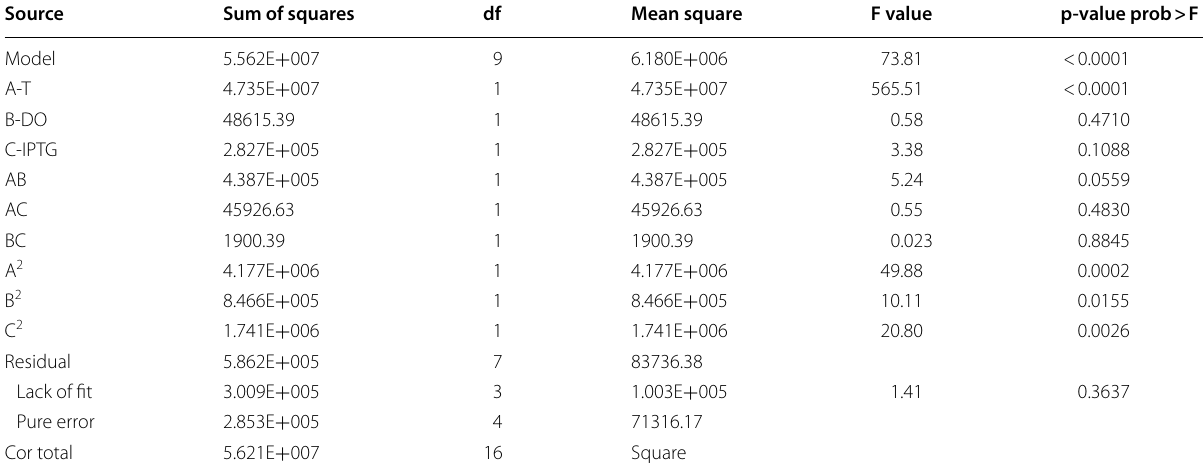
Table 3 ANOVA for Box–Behnken